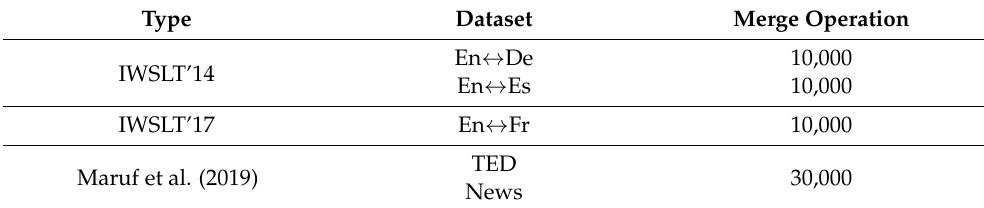
Table 2. Merge operation of each